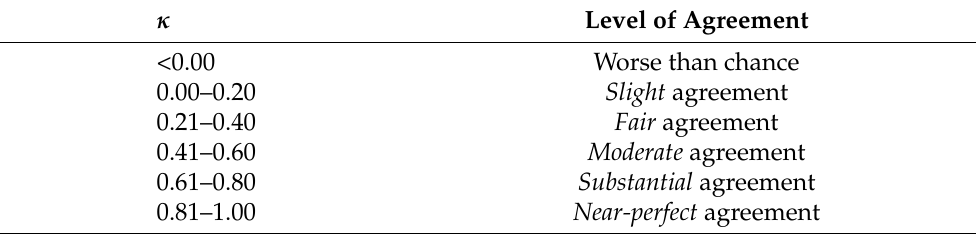
Table 11. Cohen’s Kappa